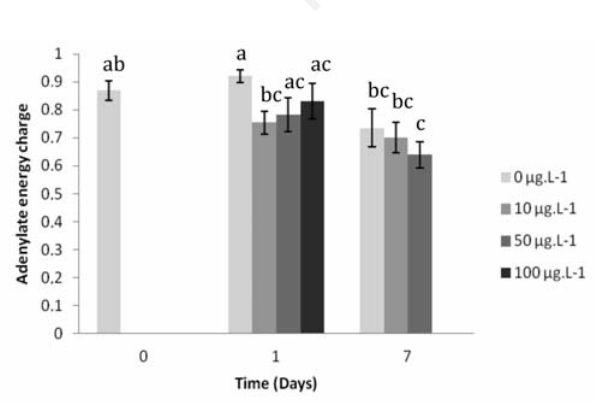
Figure 1. Relative gene expression of cytochrome c oxidase 1 dur- ing copper exposure in white muscle of roach. Different letters indicate significant differences (P<0.05). *Correspond to out- liers.